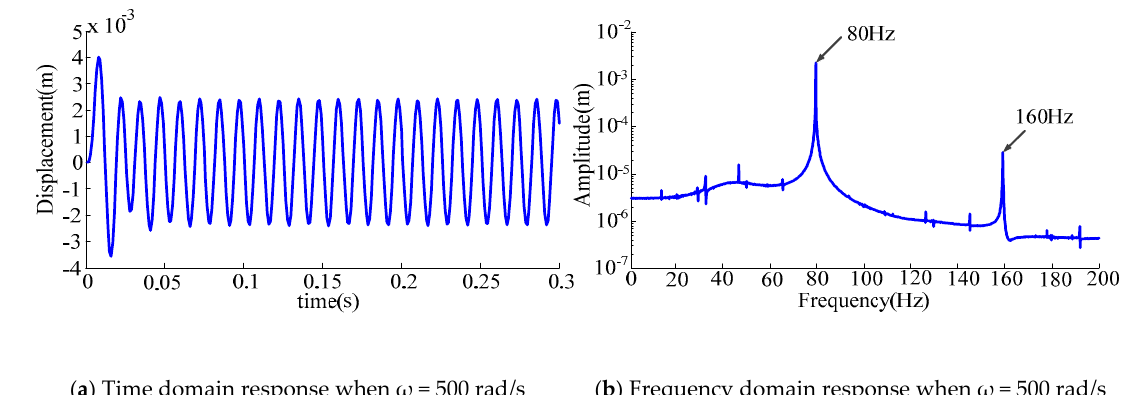
Figure 5. Response of rotor-bearing system under over critical speed condition.